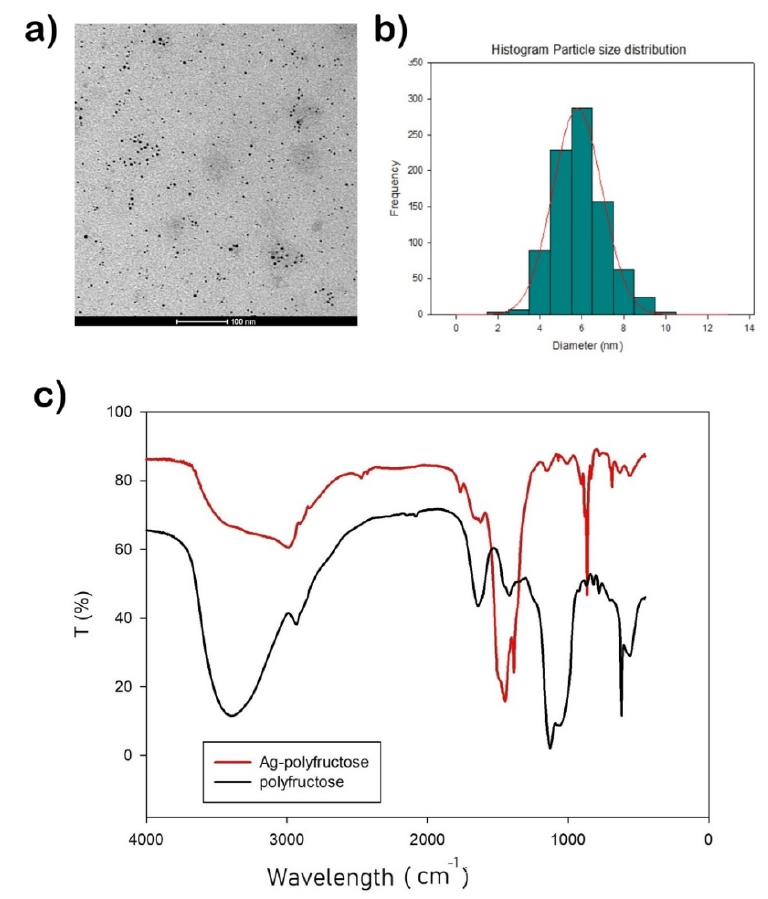
Figure 2. ( a ) Transmission electron microscopy (TEM) image of the nanoparticles synthetized. ( b ) Histogram of particle size distribution measured by Image J. ( c ) Fourier transform infrared (FT-IR_ spectra for AgLeNPs (red) and its comparison with only polyfructose chains (black).